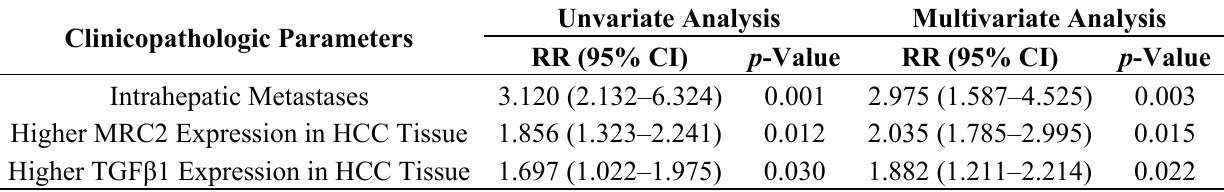
Table 2. Cox proportional-hazard regression analysis of the relationship between clinicopathologic parameters and overall survival rate of HCC Patients after liver resection. Unvariate Clinicopathologic Parameters